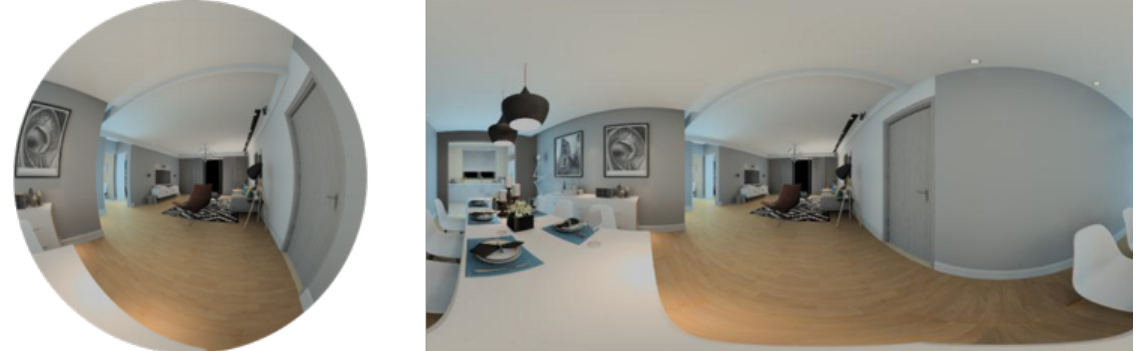
Figure 3. Panoramic spherical image and panoramic planar image. According to Equation (1), p s can be expressed as p s ( α , β ) . Therefore, p s ( α , β ) can be H respectively represent the width and height of the panoramic